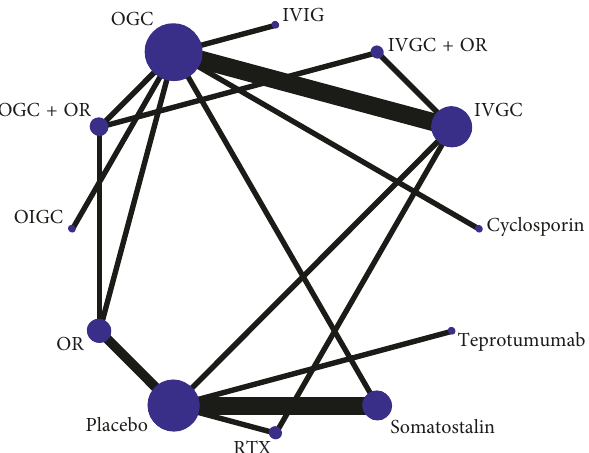
Figure 3: The evidence network of all enrolled RCTs about ten strategies in this network meta-analysis. Nodes size represents the number of trials for each strategy and lines thickness represents the number of direct